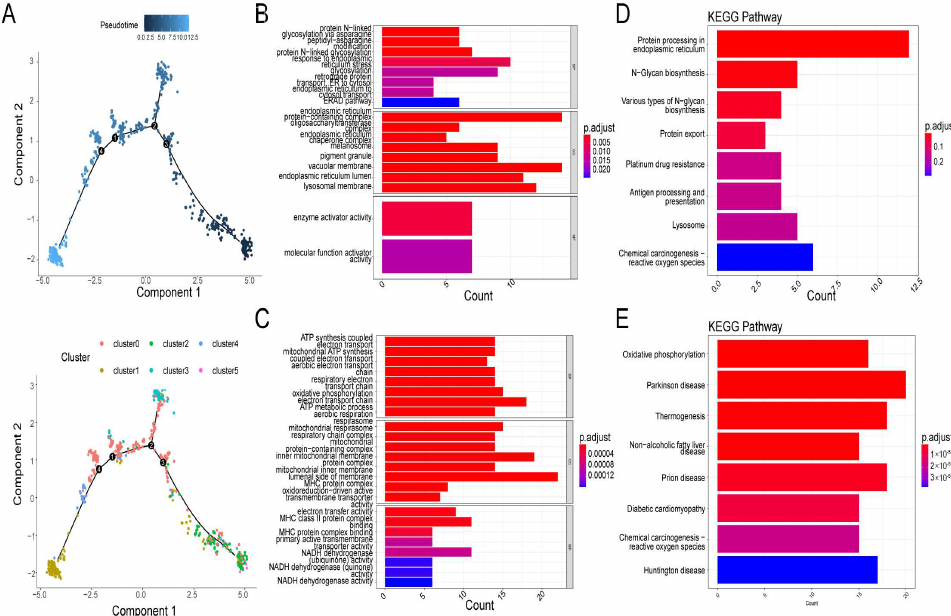
Figure 4. Reconstruction of a cell trajectory by monocle single-cell trajectory analysis. ( A ) Monocle reconstructed two main branches from a single cell trajectory. Branch 1 contains cluster 1 and cluster 4, branch 2 contains cluster 2 and cluster 5. Cells are colored based on state (left), and cluster (right). Cells in different branches have different cellular differentiation characteristics. ( B – E ) Gene ontology (GO) enrichment analysis and KEGG pathway analysis for branch−dependent genes. GO enrichment analysis ( B ) and KEGG pathway analysis ( D ) of differentially expressed genes (DEGs) in branch1. GO enrichment analysis ( C ) and KEGG pathway analysis ( E ) of DEGs in branch2.